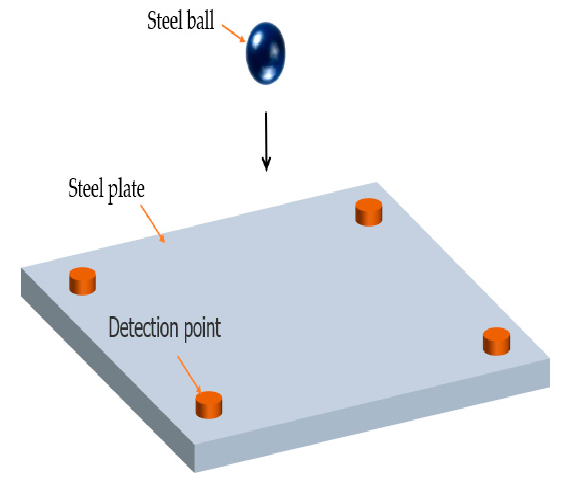
Figure 3. Impact model diagram. Table 1. Finite element model and material parameters.